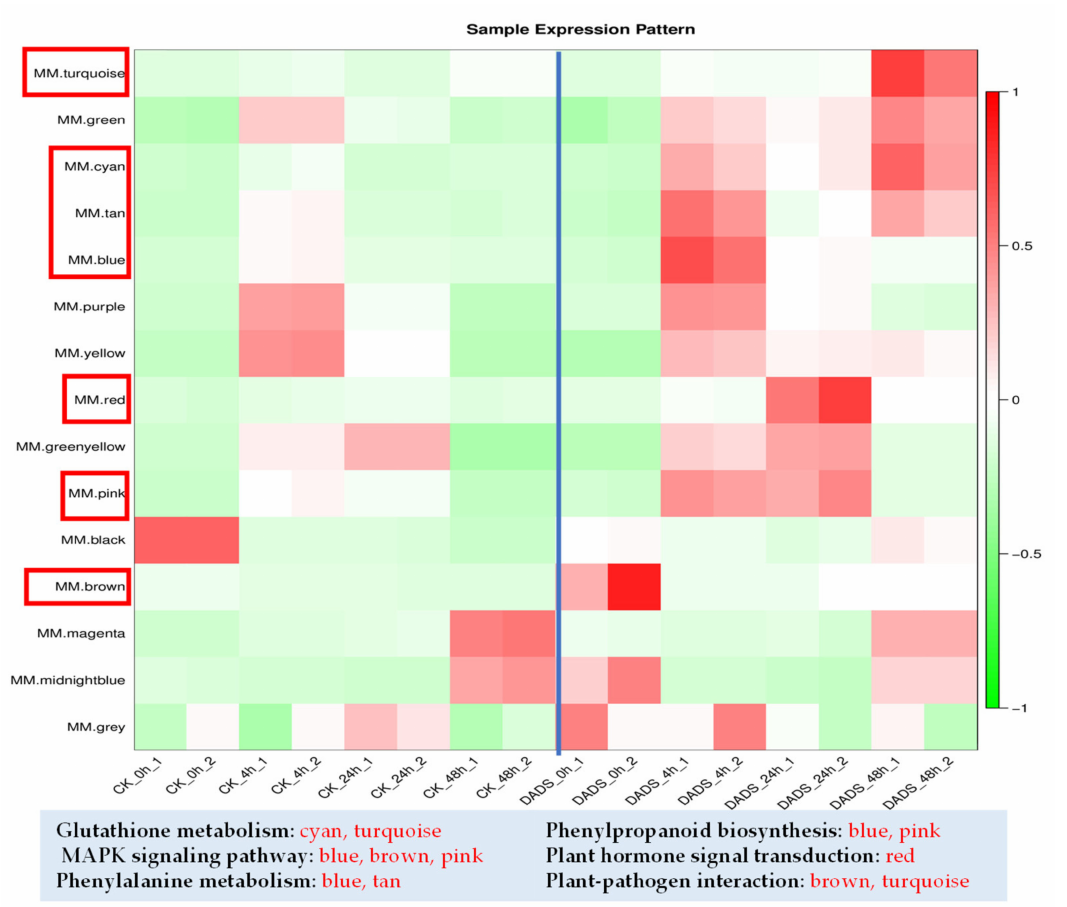
Figure 7. Expression modules constructed by WGCNA and associated KEGG of up–regulated DEGs in the ‘turquoise’, ‘cyan’, ‘tan’, ‘blue’, ‘red’, ‘brown’, and ‘pink’